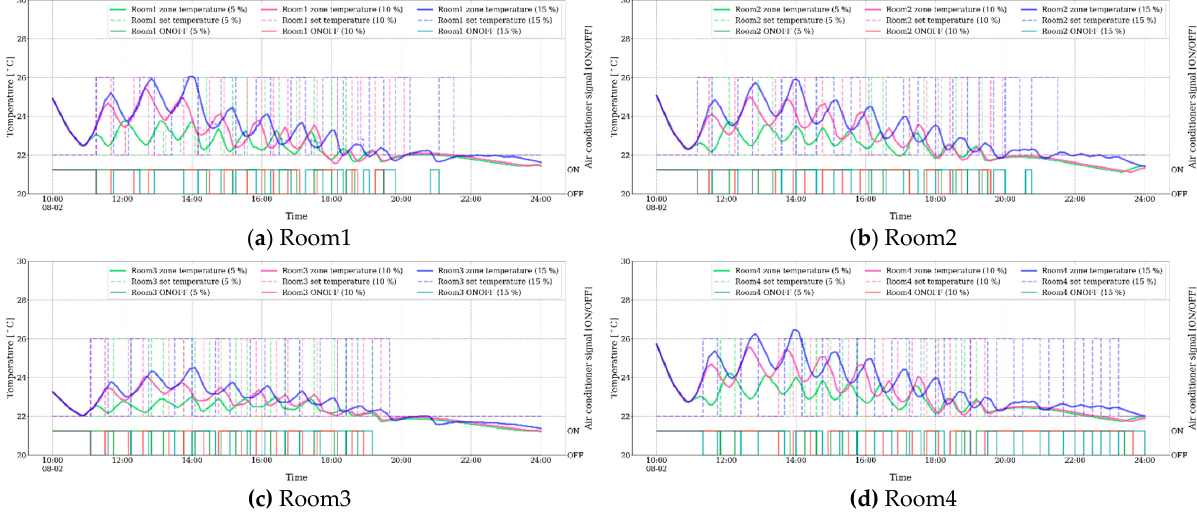
Figure 13. Simulation result with zone temperature and the number of operating air conditioners applying the building control algorithm. ( a ) Room1; ( b ) Room2; ( c ) Room3; ( d )